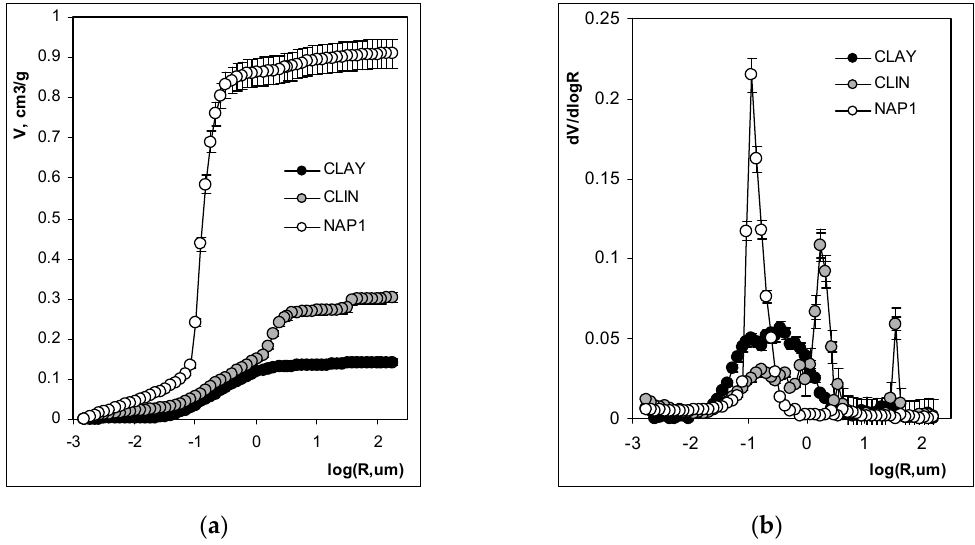
Figure 6. MIP curves ( a ) and normalized pore size distribution functions; ( b ) for the studied aggregates. The points show average results, while the error bars show maximum differences between the average and the experimental replicates.